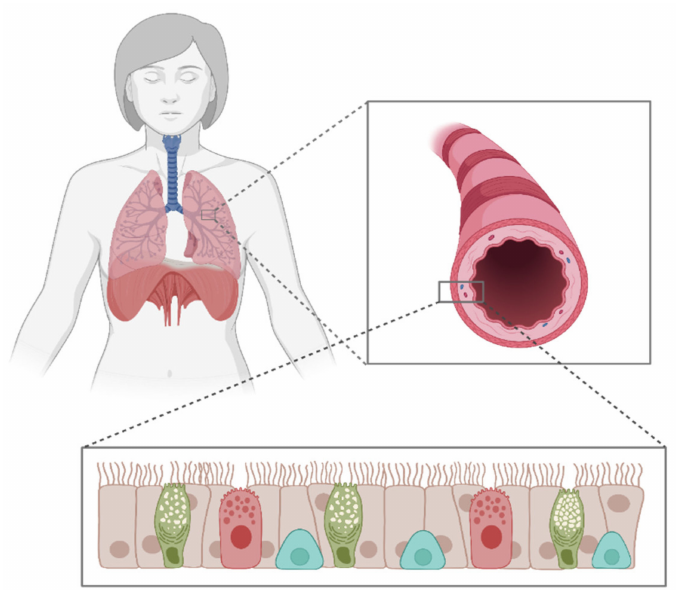
Figure 1. Cell composition along a bronchiole within the large airways. Ciliated epithelial cells (beige), mucus producing goblet cells (green), secretory cells (red) and basal progenitor cells (blue). Created with BioRender.com, accessed on 20 August